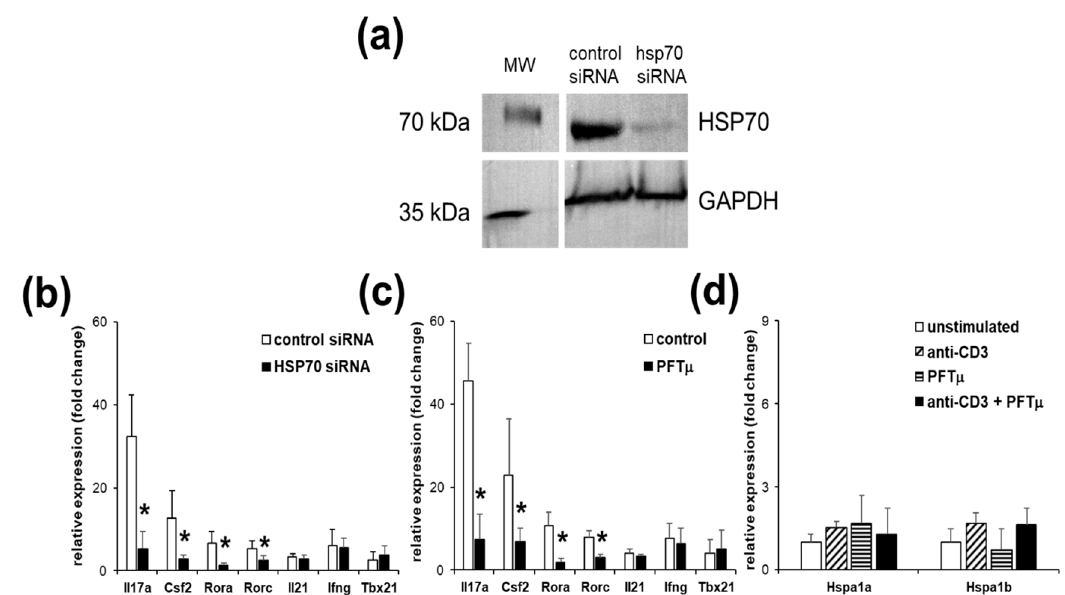
Figure 2. Heat shock protein 70 (HSP70) expression and function manipulation affects Th17 gene expression. ( a ) Western blot analysis of HSP70 and glyceraldehyde 3-phosphate dehydrogenase (GAPDH) proteins in the EL4 TCR + cells that were transfected with HSP70 siRNA or control in relation to the parallel molecular weight (MW) marker separation blot. Representative results from two independent experiments are shown. Gene expression analysis of the EL4 TCR + cells following anti-CD3 stimulation that has been transfected with HSP70 siRNA ( b ) or treated with pifithrin- µ (PFT µ ) (10 µ M) or with a control (dimethyl sulfoxide; DMSO) ( c ). ( d ) HSP70 gene expression changes of the EL4 TCR + cells following anti-CD3 stimulation or / and PFT µ (10 µ M) treatment. Data represent mean +/ − SD. * p < 0.05, Student’s t -test.